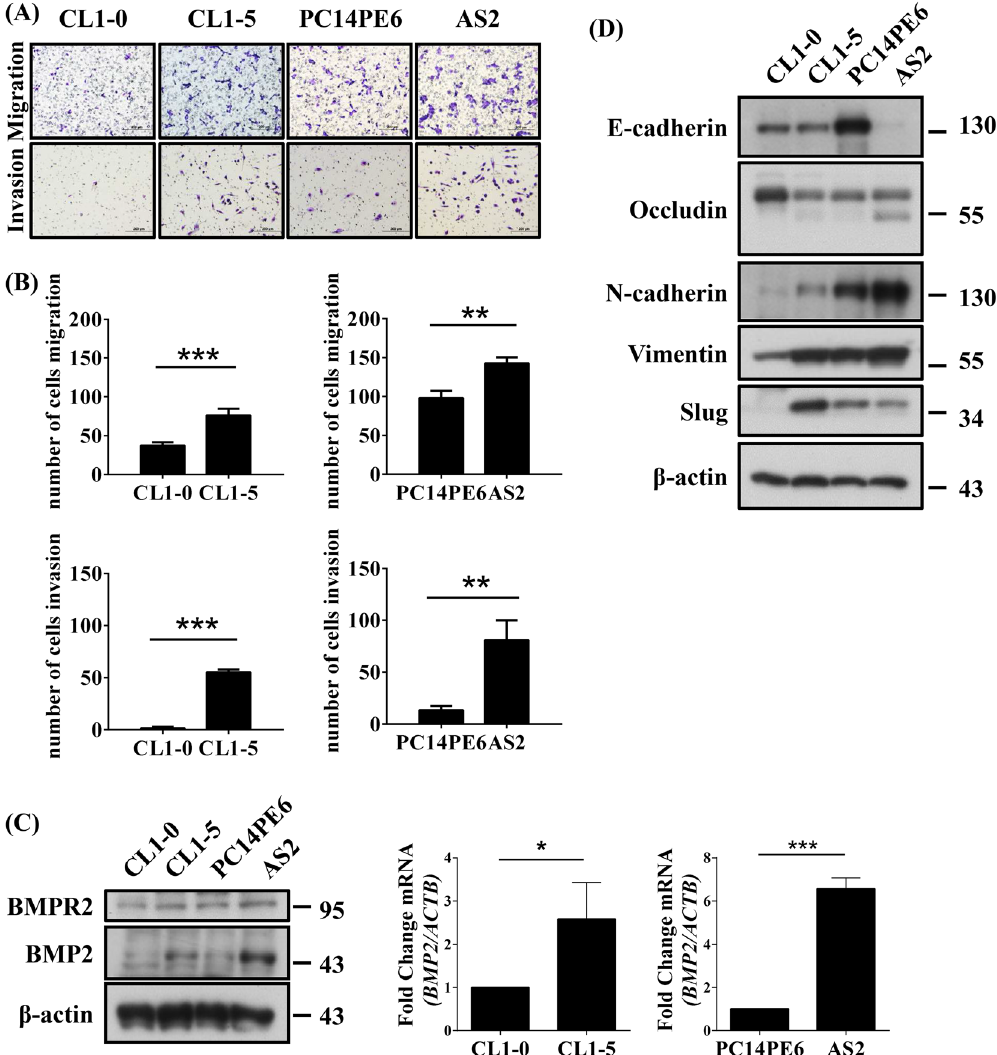
Figure 2. BMP2 is highly expressed in more invasive lung adenocarcinoma cells. ( A ) Migration ability was determined by seeding 5 × 10 4 cells in a migration chamber without Matrigel coating. Invasion ability was determined by seeding 1 × 10 5 cells in a migration chamber with Matrigel coating. After 24 h, the cells that successfully migrated through the filter were stained with Liu ‘s solution and counted. Slides were observed under 10 × magnification. ( B ) Quantitative data derived from ( A ). Bar graphs represent the average number of migrated cells ± SD. At least three fields were counted for each condition. ( C ) BMP2 and BMPR2 expression levels were determined by western blotting and qPCR. ( D ) The protein levels of epithelial and mesenchymal marker were analyzed by western blotting. The error bars represent SD, and the p -value was determined by Student’s t test (* p < 0.05; ** p < 0.01; *** p <